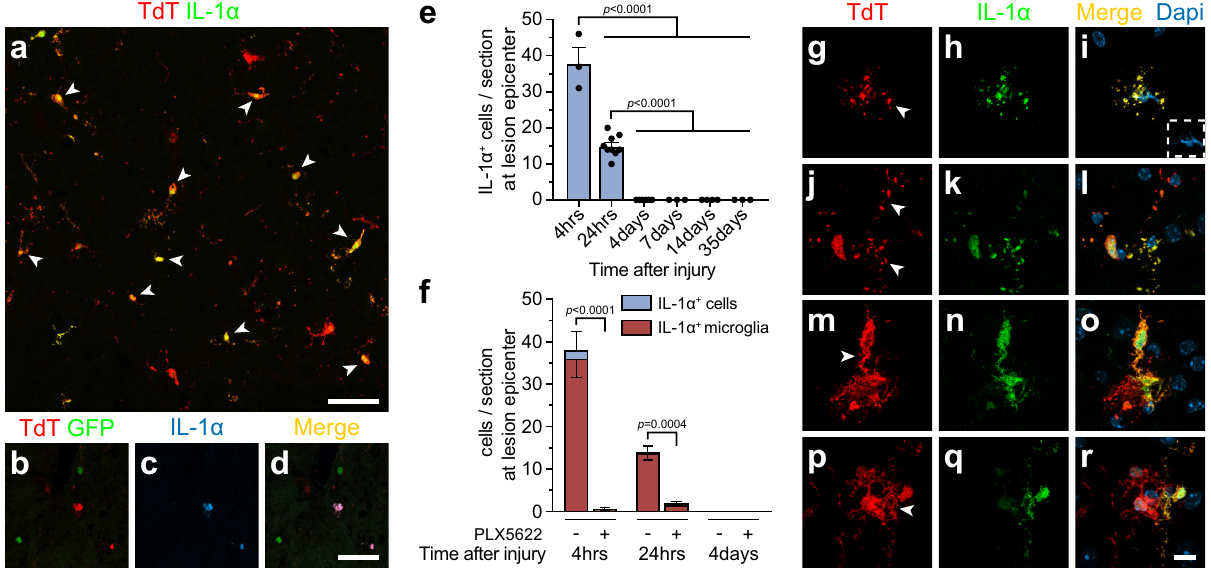
Fig. 1 | Damaged microglia rapidly produce IL-1 α at the site of spinal cord contusion in mice. a Representative confocal image showing IL-1 α immunostain- ing(green)inthespinalcordofaninjured Cx3cr1 Cre :: Rosa26 TdT transgenicmouse,in whichmicrogliaexpressthe fl uorescentreporterTd-Tomato(TdT,red),at4hpost- SCI. White arrowheads point to speci fi c double-labeled cells. b – d Confocal immuno fl uorescence images showing expression of IL-1 α (blue) in microglia (TdT, red), but not macrophages (LysM, green), in the spinal cord of an injured LysM- eGFP :: Cx3cr1 CreER :: R26-TdT mouseat4hpost-SCI. e , f Quanti fi cationofIL-1 α -positive (+) cells and IL-1 α + TdT + microglia at the lesion epicenter in untreated Cx3cr1 Cre :: R- osa26 TdT mice ( e n =3 at 4h, n =9 at 24h, n =6 at 4 days, n =3 at 7 days, n =4 at 14days, n =3at35days)and fl uorescentreportermicetreatedwithPLX5622orthe